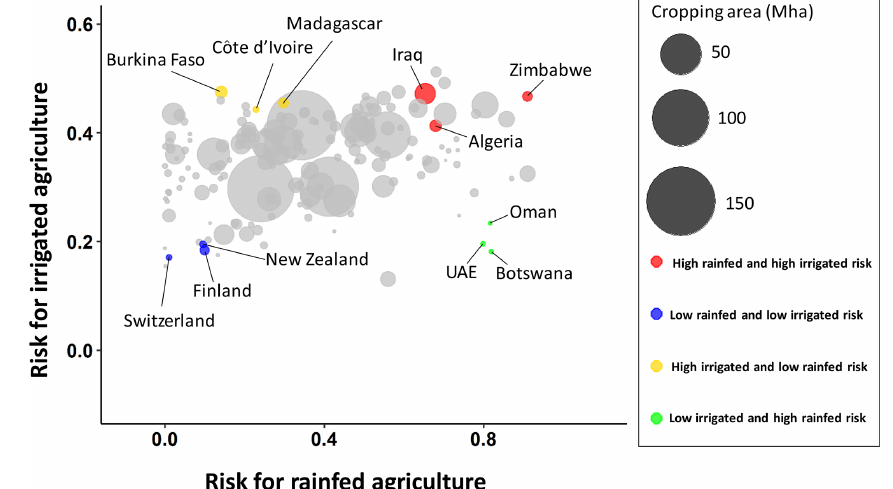
Figure 5. Country profiles contrasting the drought risk of irrigated and rainfed agricultural systems. The size of the bubbles indicates the crop growing area (sum of rainfed and irrigated areas per country in Mha.